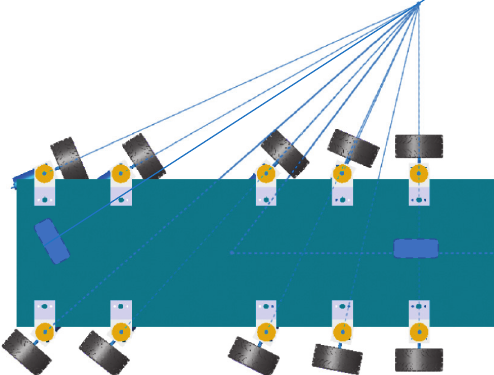
Figure 6: Nonsteering last-axle wheel mode.